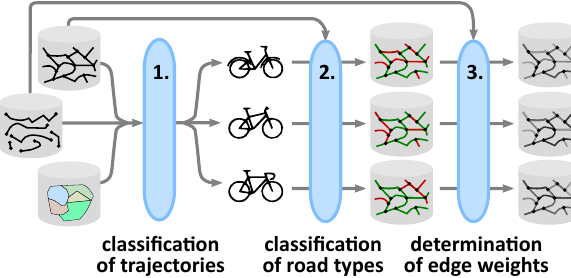
Figure 2. An overview of our method for the identification of cyclist groups and their routing preferences. After a data acquisition from different sources, a multi-source data analysis consisting of three steps is